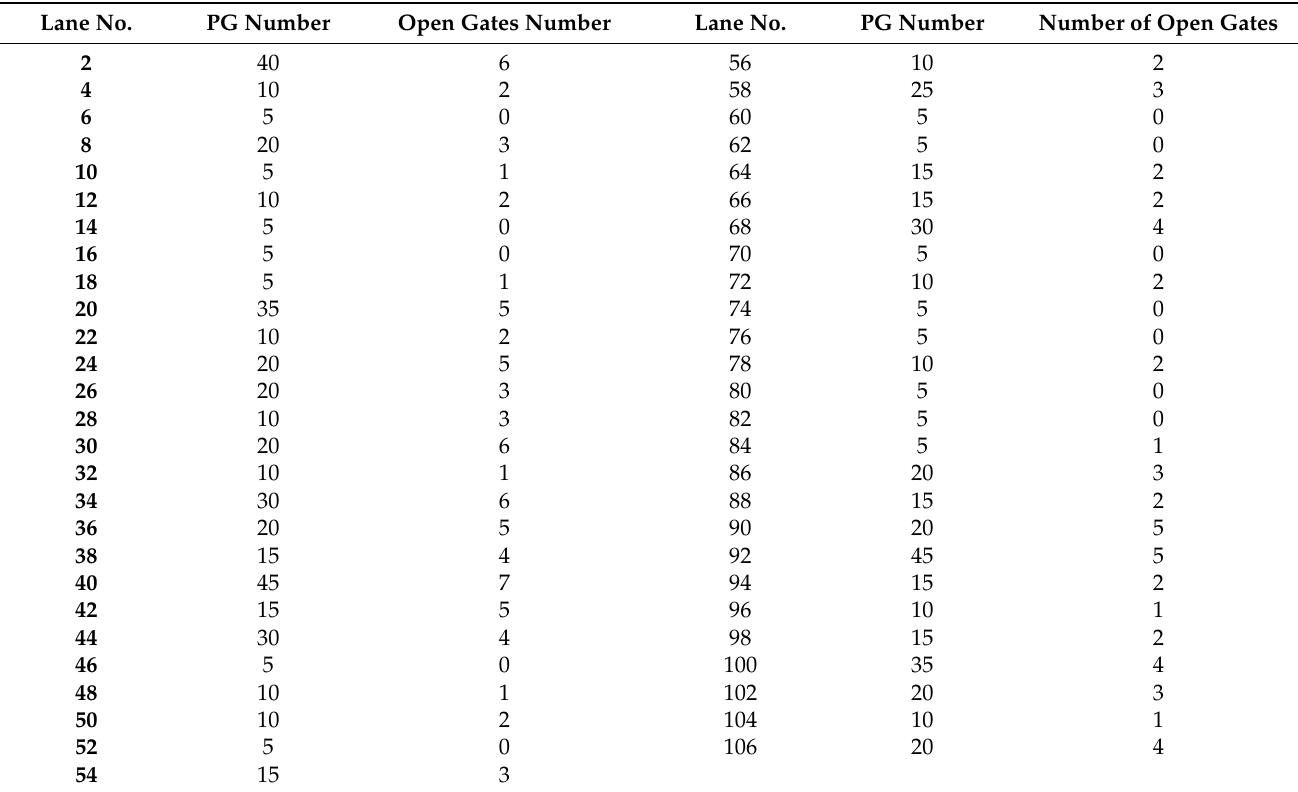
Table 6. Number of open gates in each charging lane for solution